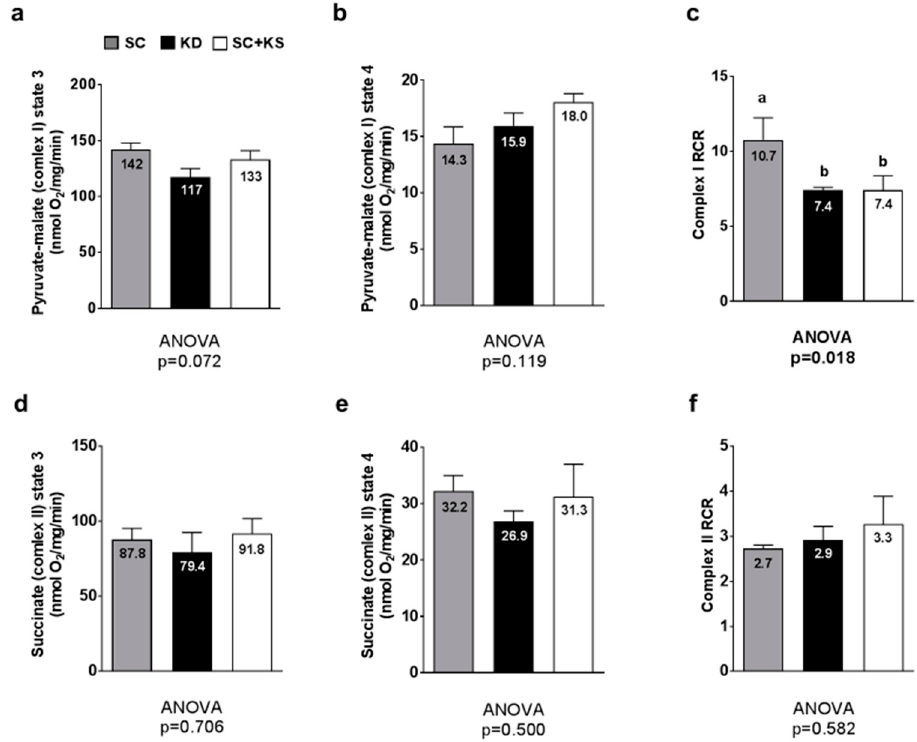
Figure 9. Gastrocnemius mitochondrial function in 8 month-fed rats. Legend: State 3 pyruvate-malate